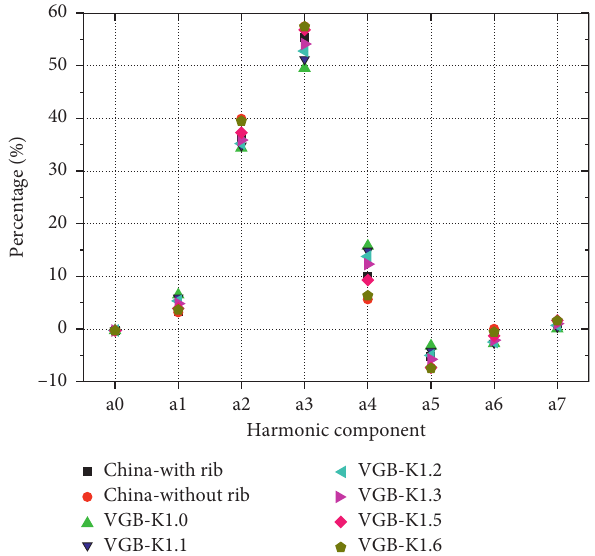
Figure 18: Percentage of each harmonic displacement (middle